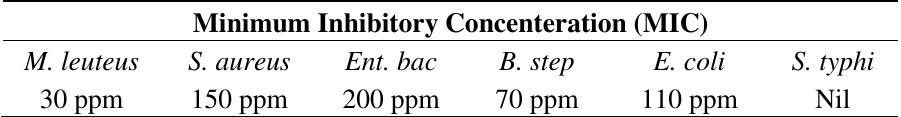
Table 3. Bacteriological